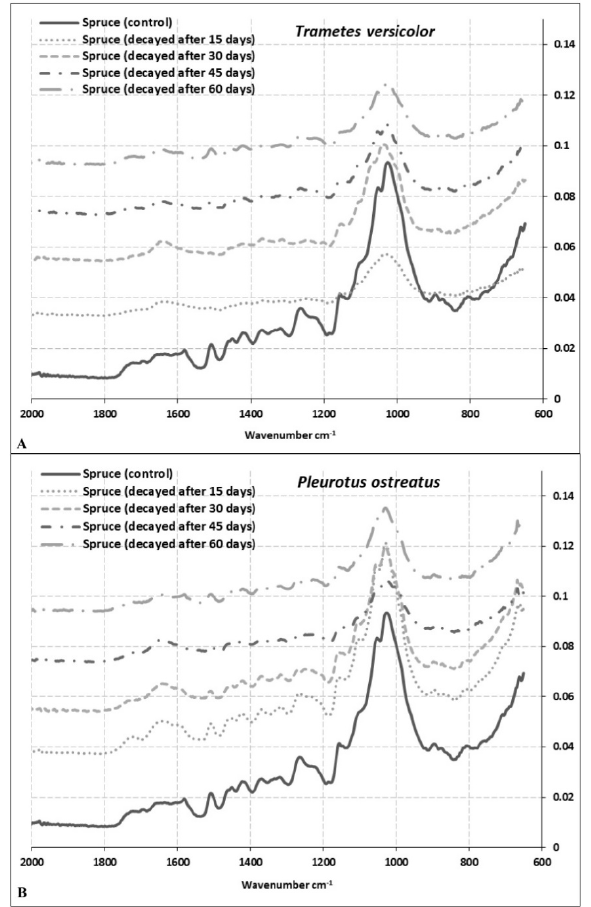
Figure 3. Total FT-IR spectra of spruce wood samples exposed to T. versicolor ( A ) and P. ostreatus ( B ) for 60 days.